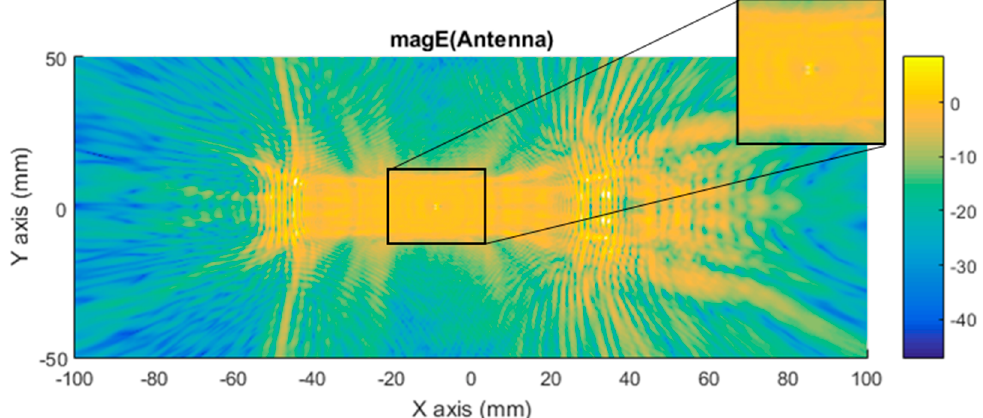
Figure 8. Distribution of near electric field magnitude (in logarithmic scale) of the three components with antenna (ON state), evaluated on a plane in contact with the top of the car, illuminated at 300 GHz. The region where antenna monopole diffraction pattern is identified is zoomed. Figure generated by MATLAB software using the complex near electric field raw data obtained at each point of the plane based on a simulation using Ansys HFSS software.